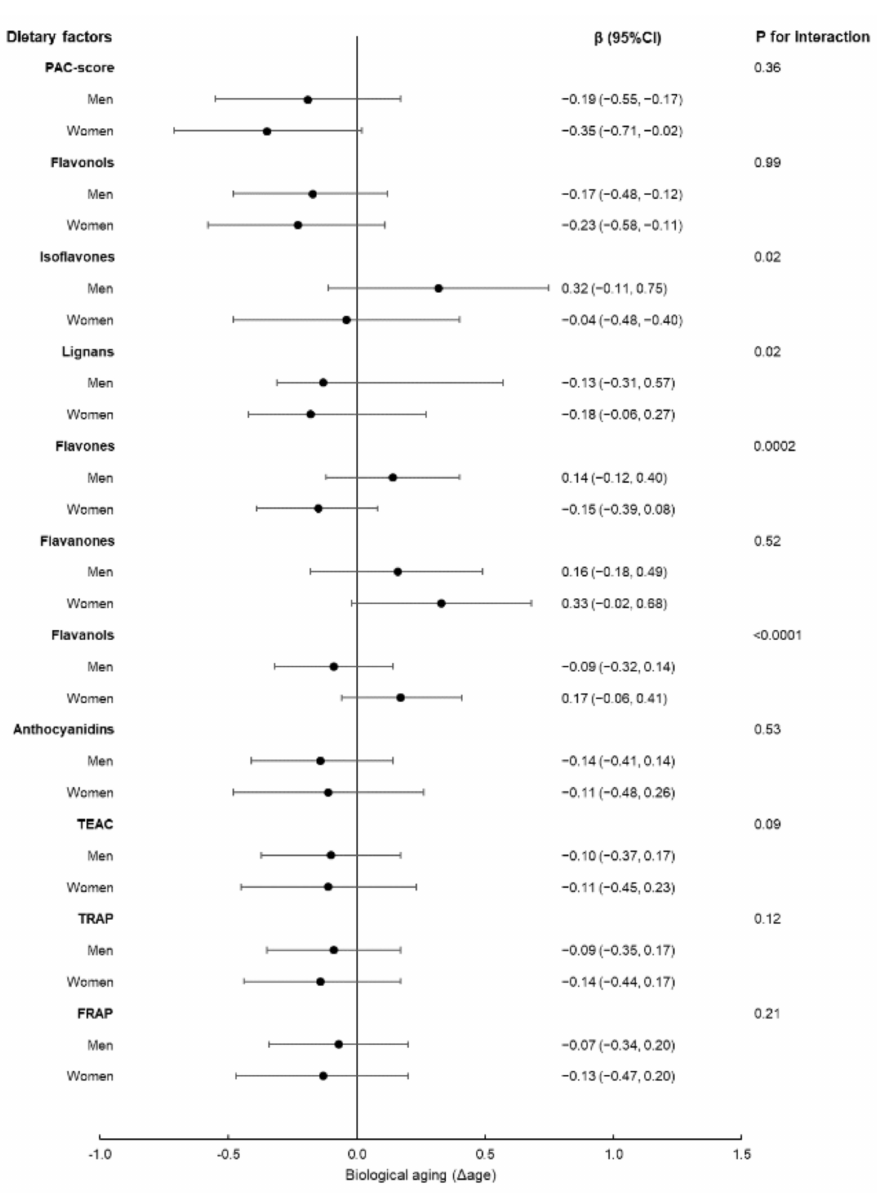
Figure 1. Association of the PAC-score, polyphenol classes and sub-classes and total antioxidant capacity with ∆ age in men ( N = 2211) and women ( n = 2381), by means of regression coefficients ( β ) with 95% confidence interval (95%CI). Multivariable-adjusted regression model adjusted for age, sex, energy intake, educational level, leisure-time physical activity, smoking habit, BMI, CVD, cancer, diabetes, hypertension and hyperlipidaemia, menopausal status, hormone replacement therapy and dietary fibre